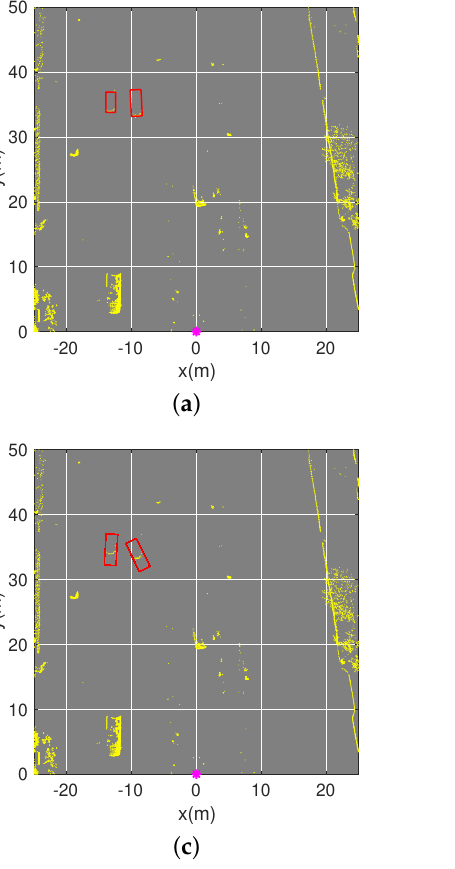
Figure 10. Pose estimation of two vehicles in the scenario. ( a ) Ground truth of their poses. ( b – d ) Estimated poses with the proposed pose estimation based on coherent point drift (PE-CPD), convex-hull model, and the proposed PE-CHM algorithm, respectively. Experiments were implemented one hundred